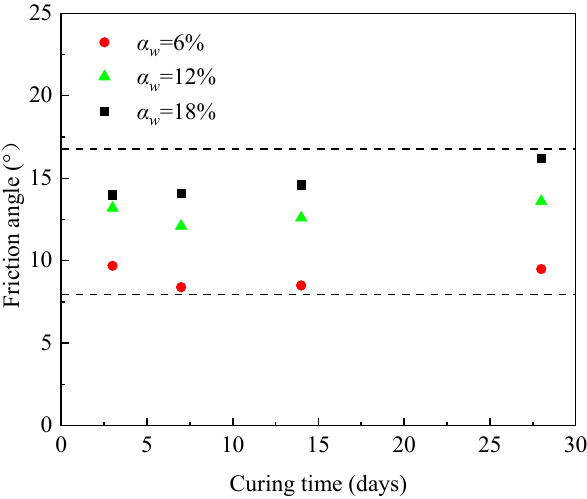
Figure 12. Correlation between the internal friction angle and cement content.